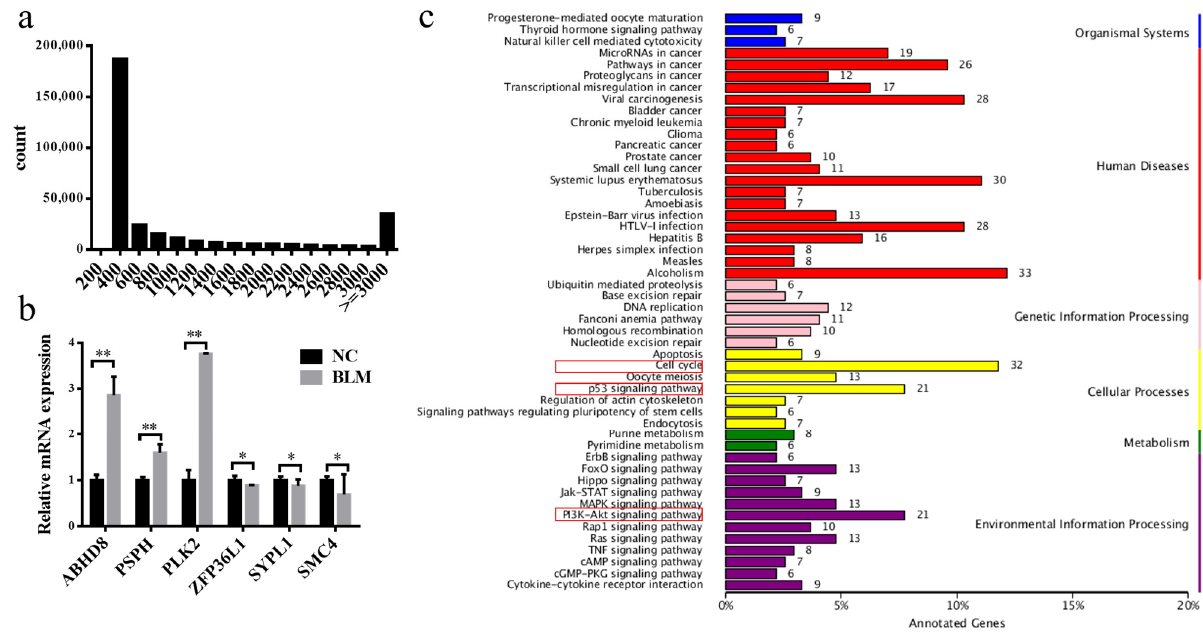
Figure 2. Identification of differentially expressed mRNAs. ( a ) MRNA length analysis. ( b ) Expression of up- and downregulated mRNAs in the NC or BLM group, as determined by RT–PCR. ( c ) KEGG pathway analysis of differentially expressed mRNAs. Red box is a relevant path for highlight DSBs or DDR. Significant differences are represented with * ( p < 0.05) and ** ( p <